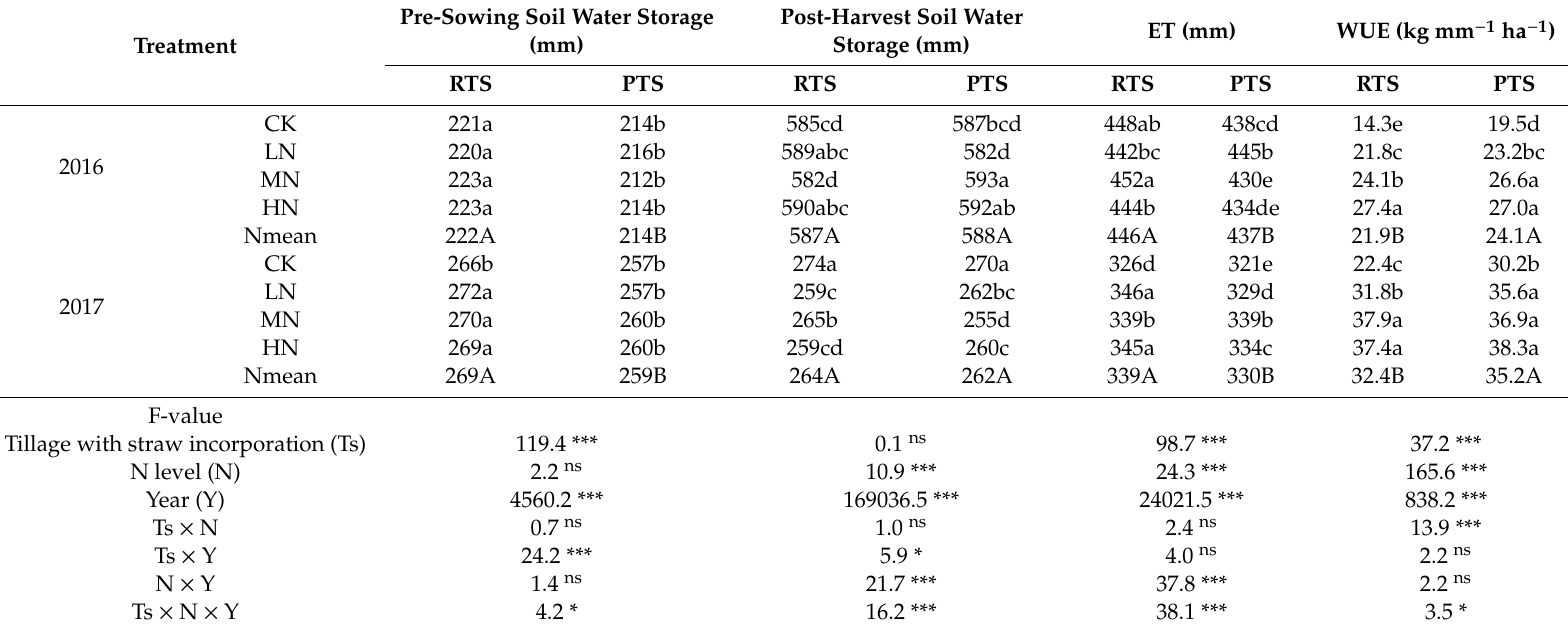
Table 2. E ff ect of tillage with straw incorporation and N treatment on the amount of soil water storage (0–200 cm), field evapotranspiration (ET), and water use e ffi ciency (WUE) of